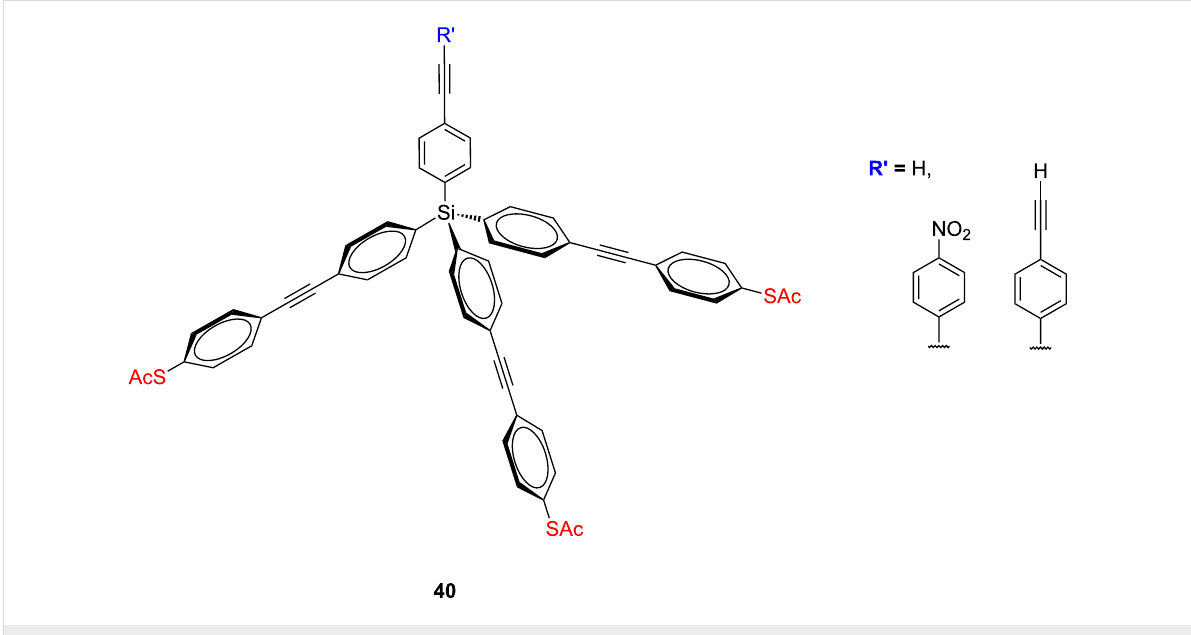
Figure 19: Tetraphenylsilane-based platforms 40 .